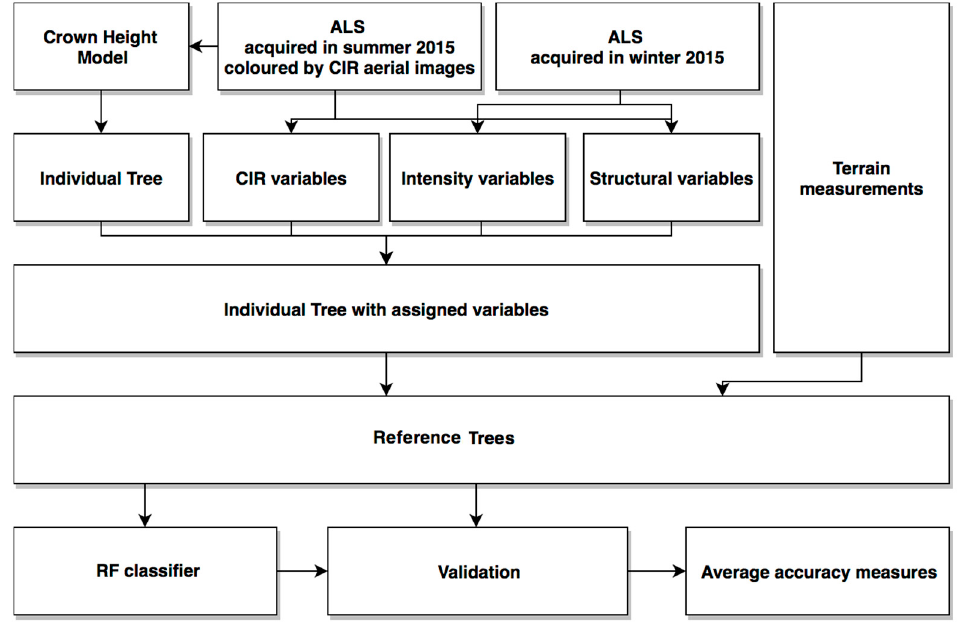
Figure 3. Methodological framework developed in this study.